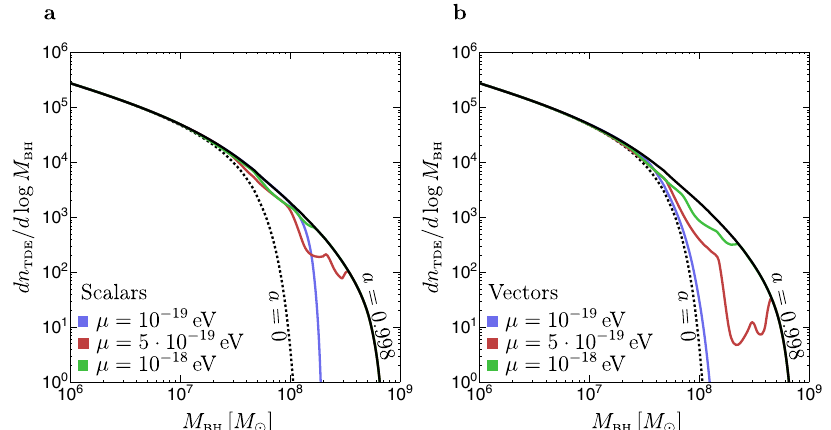
Fig. 4 | Expected differential TDE counts at the Vera Rubin ’ s LSST. The differ- ential counts are shown as a function of the SMBH mass M BH . The different lines correspond to different SMBH spin models, speci fi ed in the caption of Fig. 3.